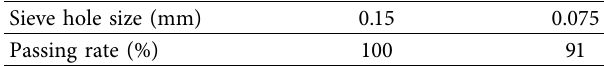
Table 13: Slag powder sieving passing